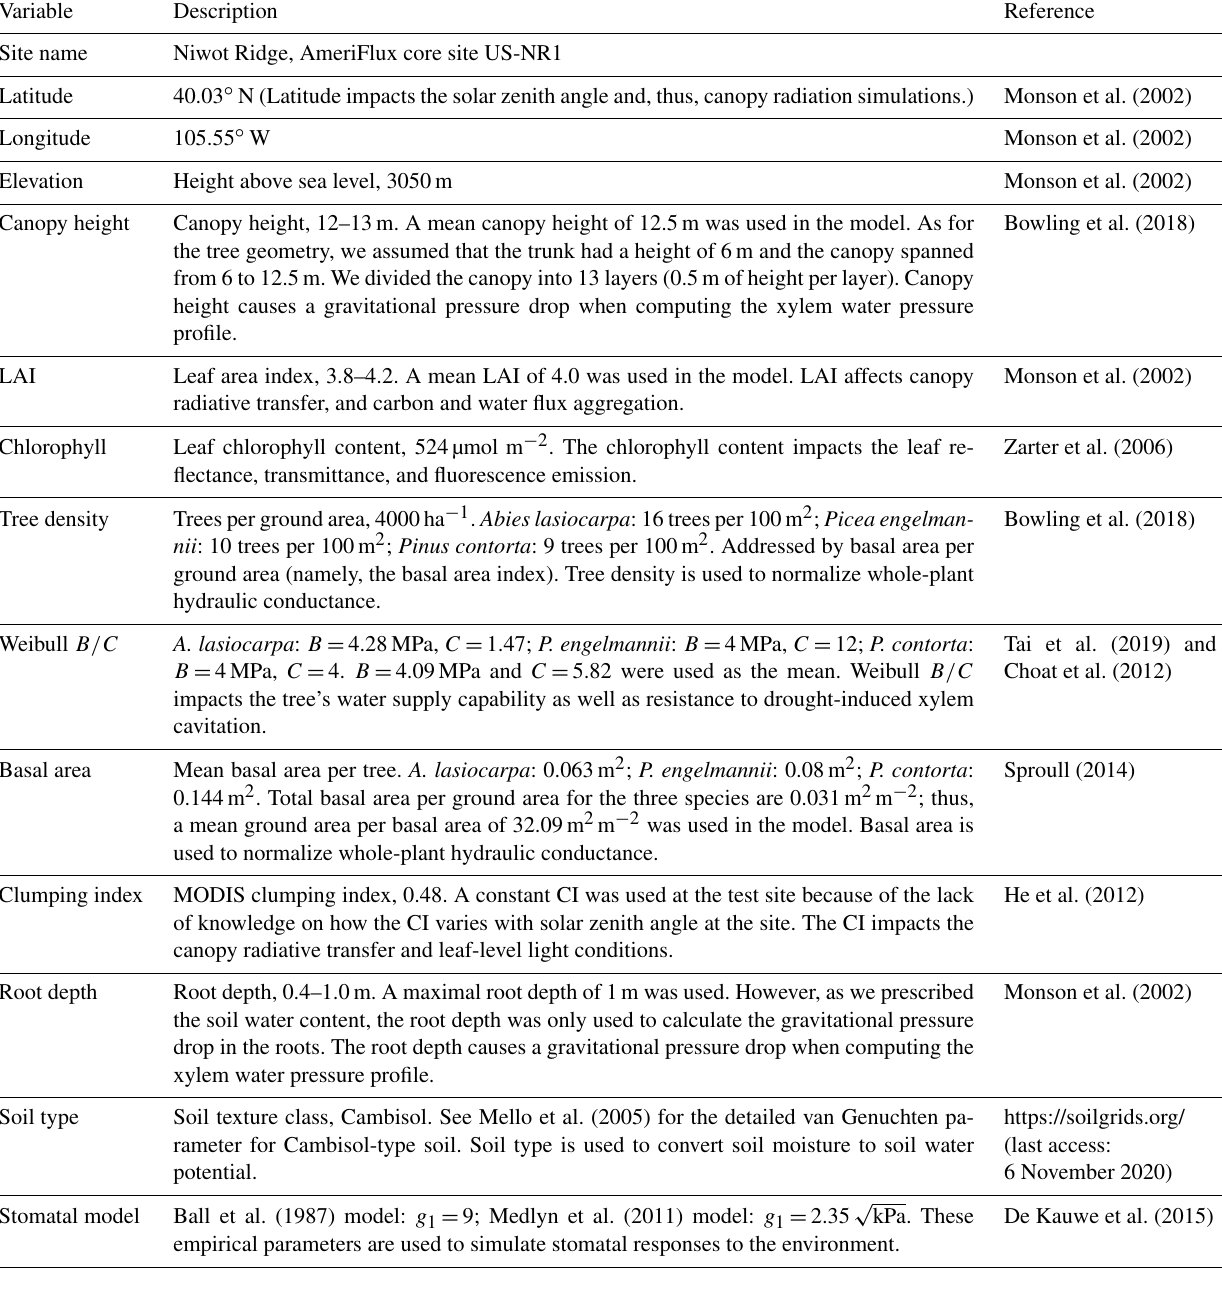
Table 1. Site and plant information of the Niwot Ridge flux tower